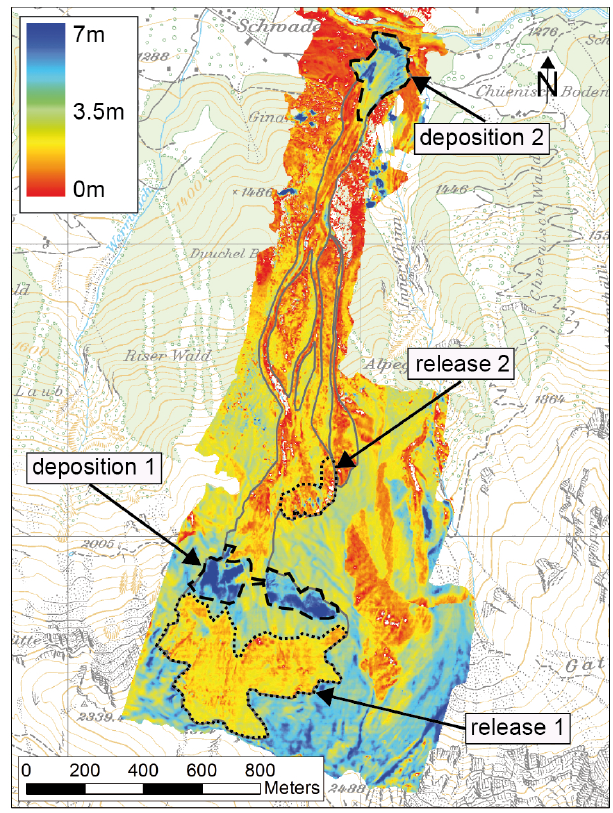
Fig. 5. Calculated snow depth, h s in the Gatschiefer avalanche track after the event of April 2008. Dotted contours show release zones ] 1 and ] 2, as well as deposits ] 1 and ] 2.